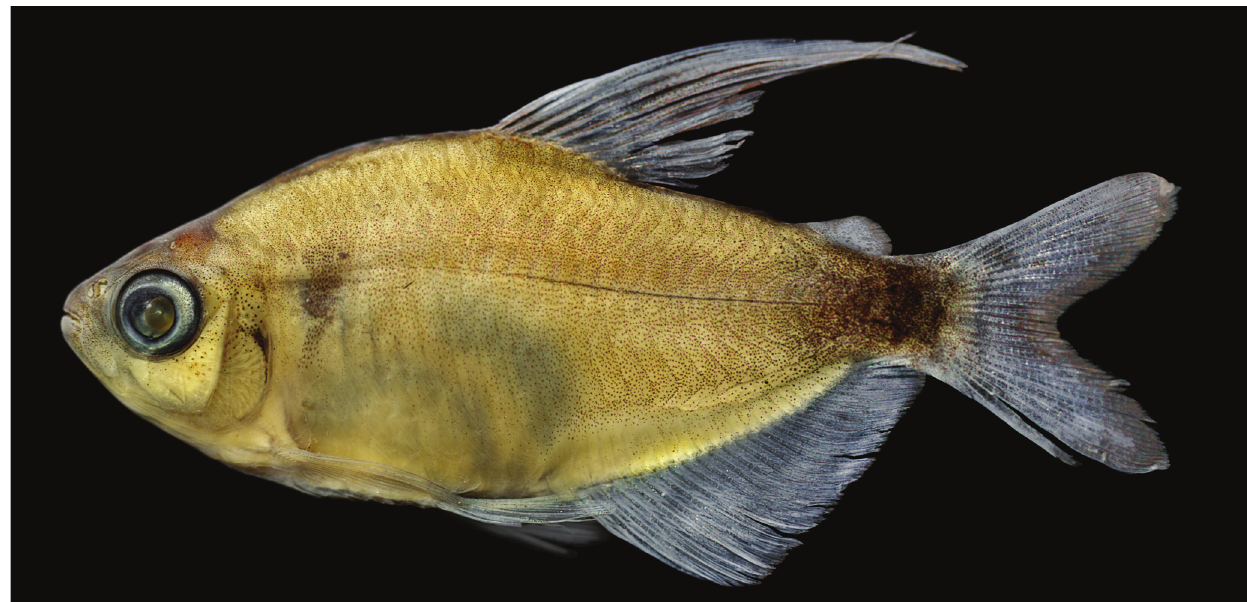
Fig. 1. Hyphessobrycon peugeoti new species, holotype, MNRJ 38988, 38.5 mm SL, male, Brazil, Mato Grosso State, Cotriguaçu, tributary of rio Juruena.